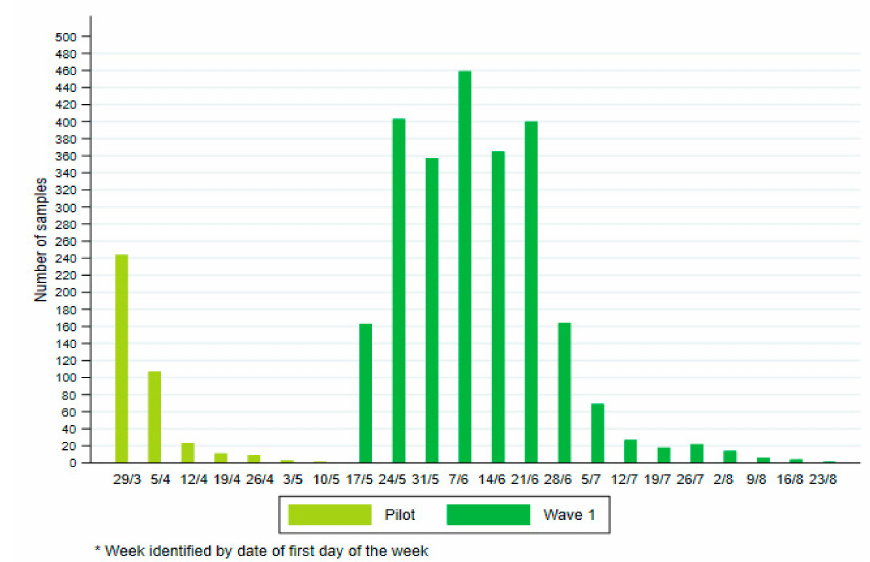
Figure 1. Number of saliva samples collected in the SalivaHIS study per